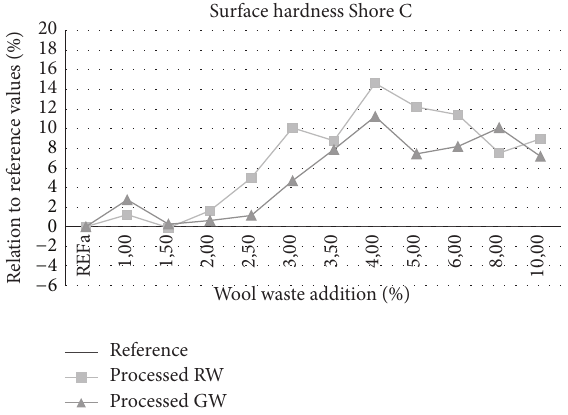
Figure 8: Comparison of the surface hardness Shore C between the series and the reference